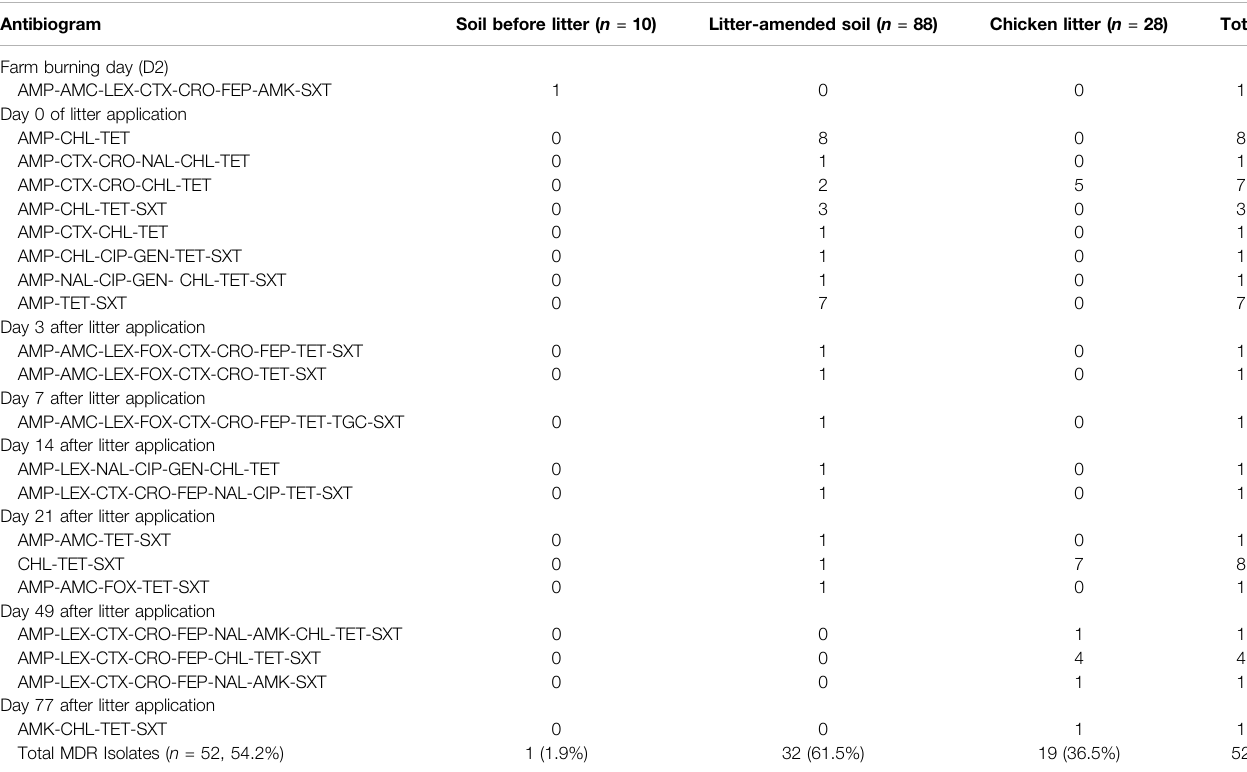
TABLE 2 | Multidrug-resistance patterns of the E. coli isolates. Antibiogram